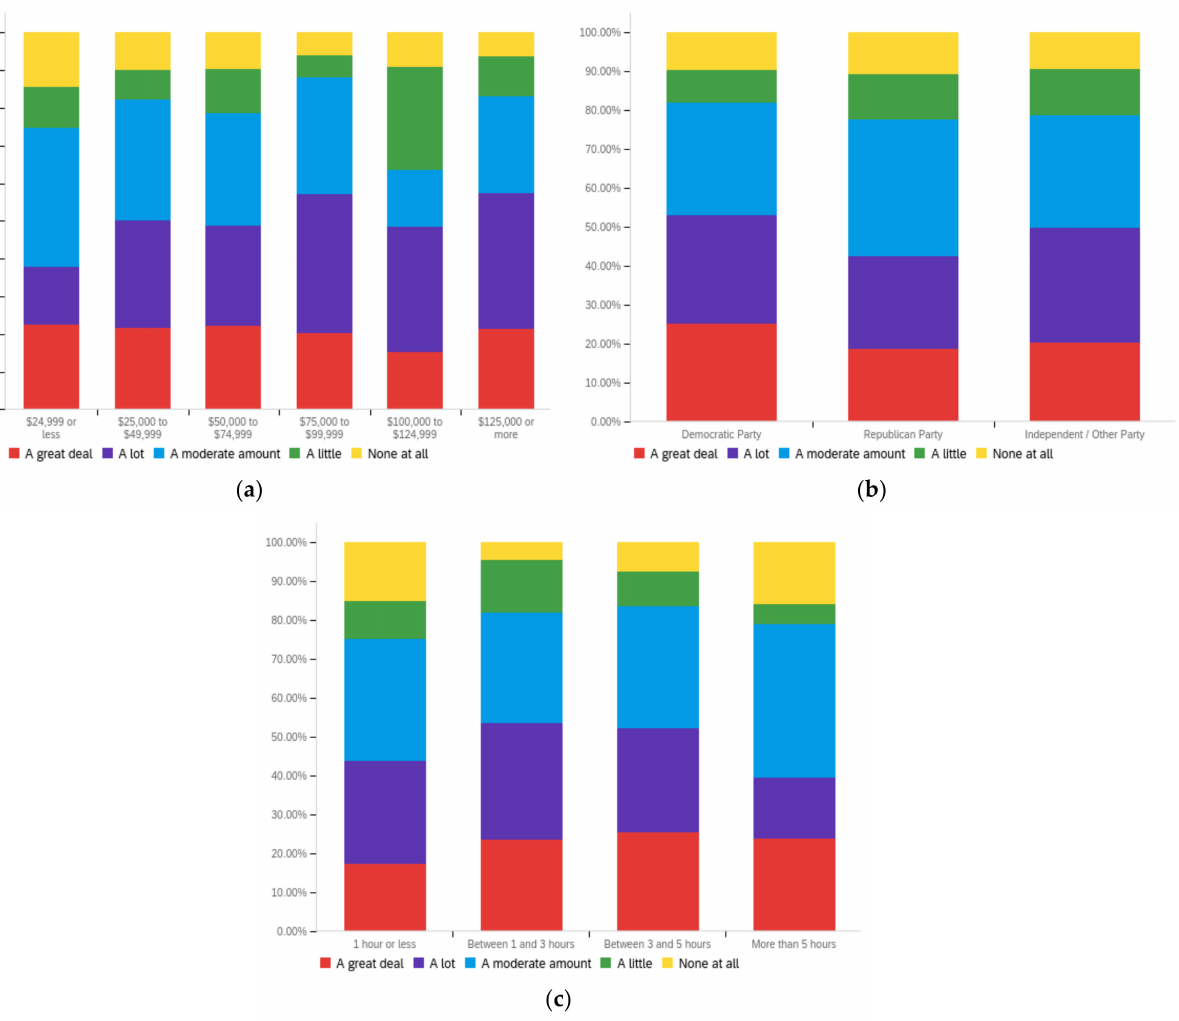
Figure A22. Article sponsor’s political alignment—personal perception impact by: ( a ) income level (top left), ( b ) political affiliation (top right) and ( c ) online usage (bottom).